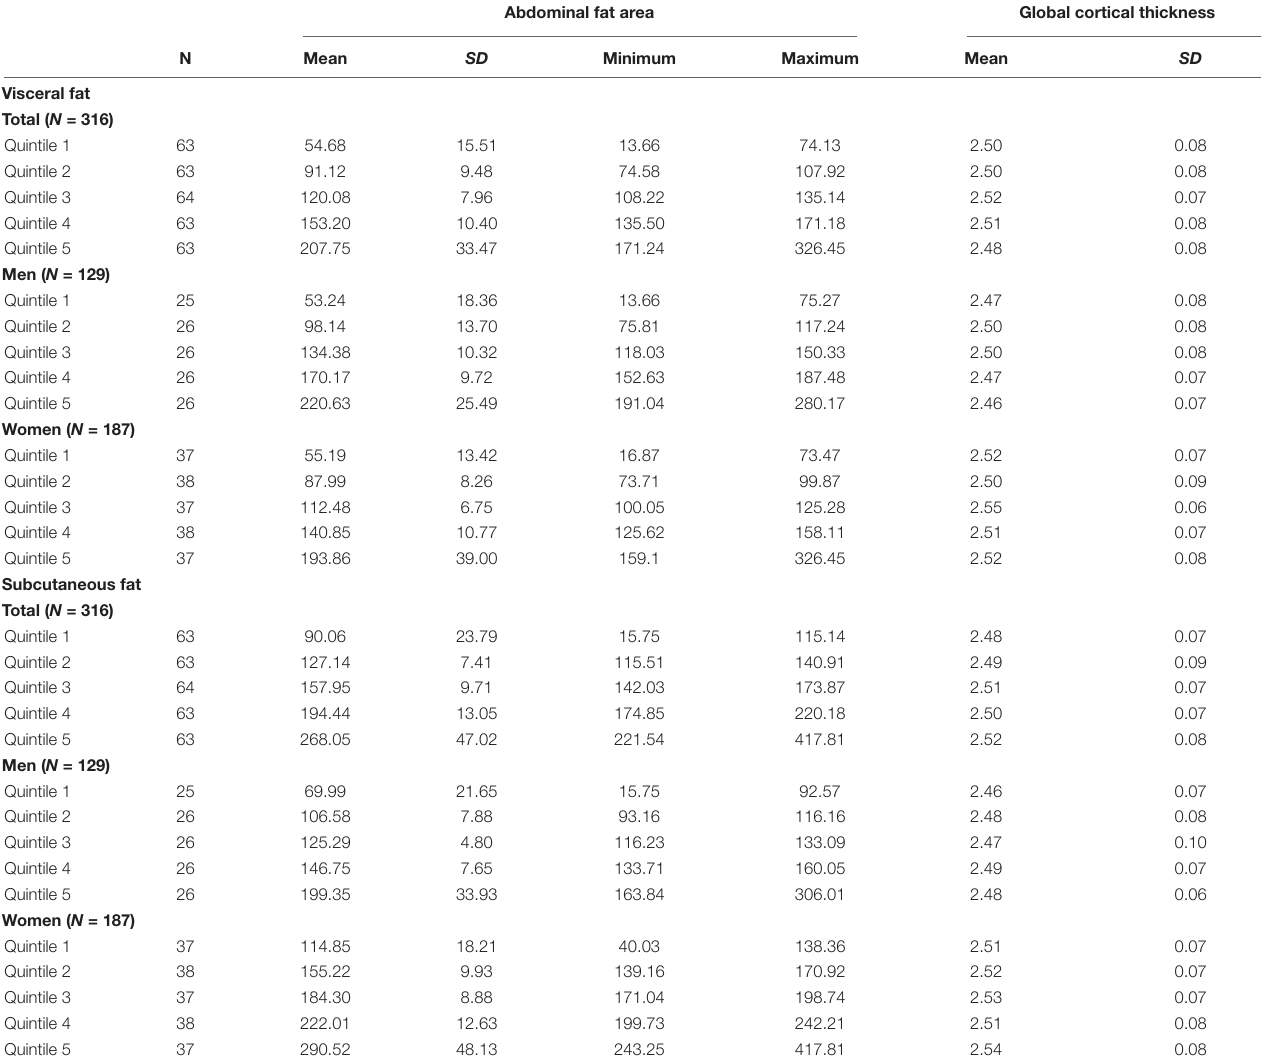
TABLE 2 | Global cortical thickness by quintiles of abdominal fat